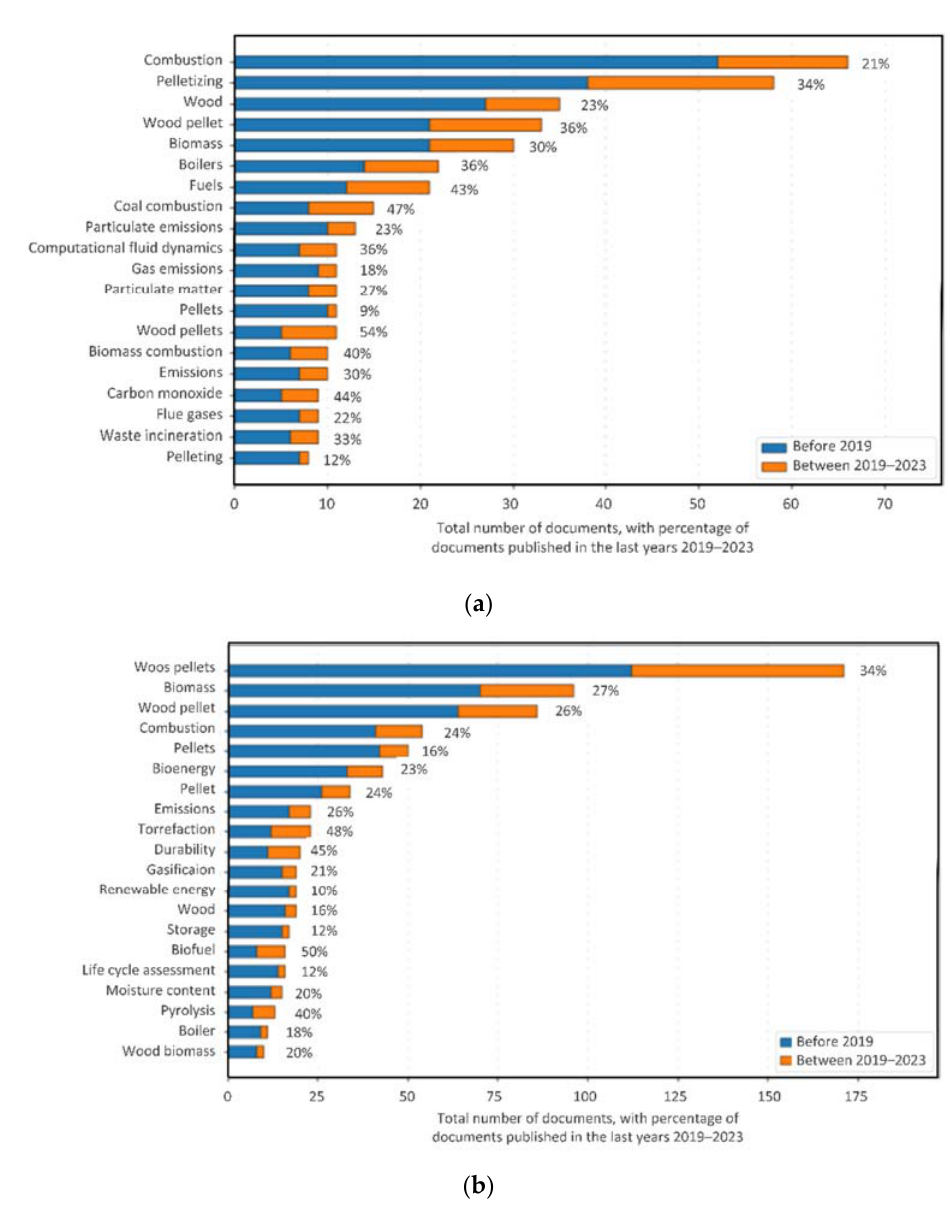
Figure 1. Keywords utilized in the study: ( a ) wood pellet, ( b ) wood pellet combustion analyzed using ScientoPy.